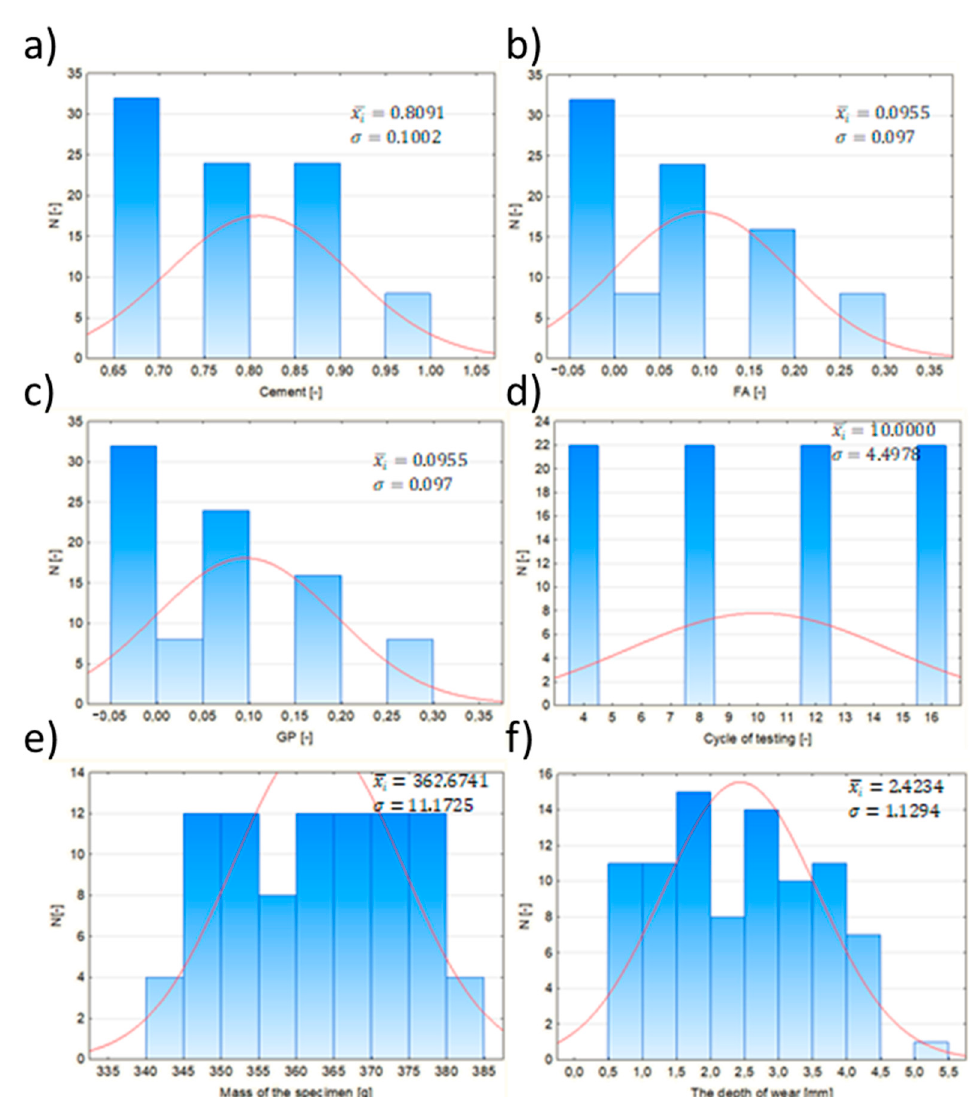
Figure 8. Histograms with mean average ( x ) and standard deviation (cid:4666)σ(cid:4667) for ( a ) cement, ( b ) fly ash, ( c ) granite powder, ( d ) cycle of testing, ( e ) mass of the specimen, and ( f ) the depth of wear. For a chosen alpha level and significance α = 0.01, according to the null hypothesis of the Shapiro-Wilk test, if the p -value is less than the alpha level, the null hypothesis is rejected and the data tested are not normally distributed. If the p -value is greater than the chosen alpha level, the null hypothesis that the data came from a normally distributed population cannot be rejected [30]. The results of the Shapiro-Wilk test are presented in Table